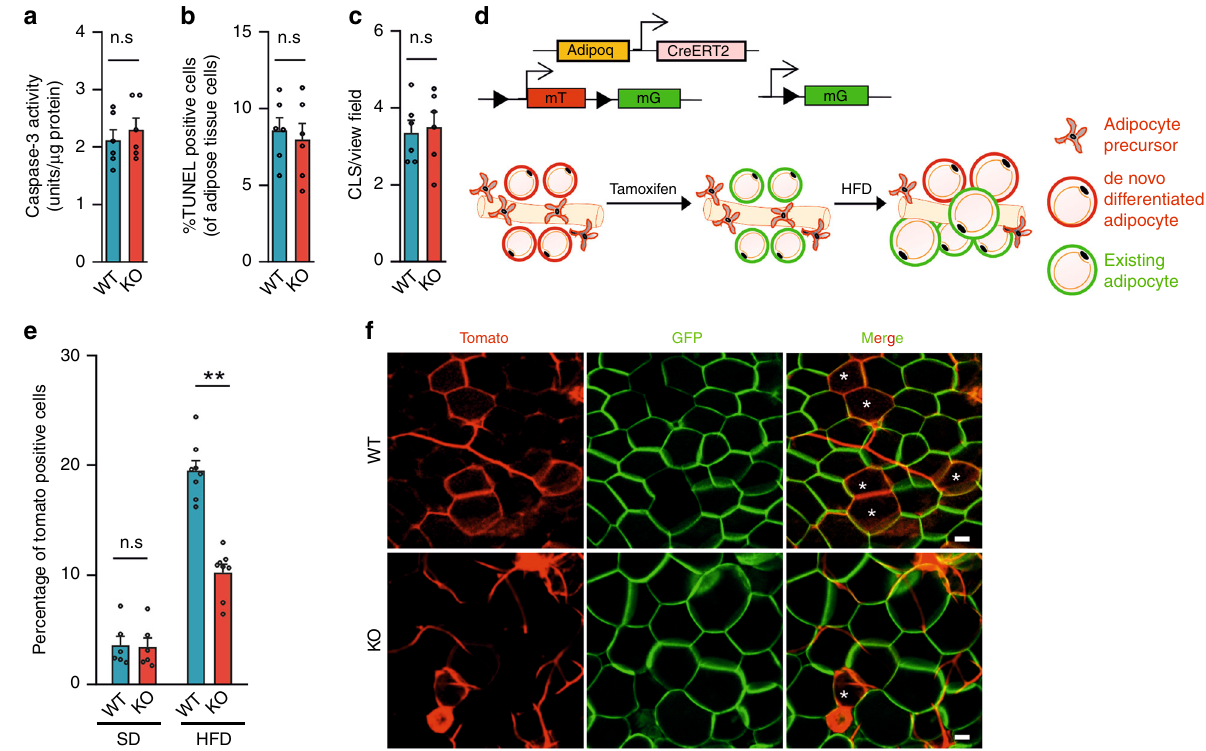
Fig. 3 Analysis of in vivo adipogenesis in Ad-Piezo1-KO mice. a – c Caspase-3 activity ( a ), TUNEL staining ( b ) and crown-like structures (CLS; c ) in vWAT from wild-type (WT) and Ad-Piezo1-KO mice (KO) fed HFD for 16 weeks ( n = 6 mice (at least 10 sections per mouse in b , c )). d Experimental design of analysis of adipogenesis in vivo using Adipoq-CreERT2;mT/mG mice. e , f Statistical analysis (at least 20 sections per mouse; e ) and representative images ( f ) of adipocyte tracing in Adipoq-CreERT2;mT/mG;Piezo1 fl ox/ fl ox (KO) and Adipoq-CreERT2;mT/mG;Piezo1 + / + mice (WT) after tamoxifen treatment and 8 weeks of HFD or SD in vWAT ( n = 6 mice (SD), n = 8 mice (HFD)); bar length: 50 μ m. Shown are mean values± s.e.m.; ** P ≤ 0.01; n.s., not signi fi cant (two-tailed non-parametric Mann – Whitney U -test). Source data are provided as a Source data fi